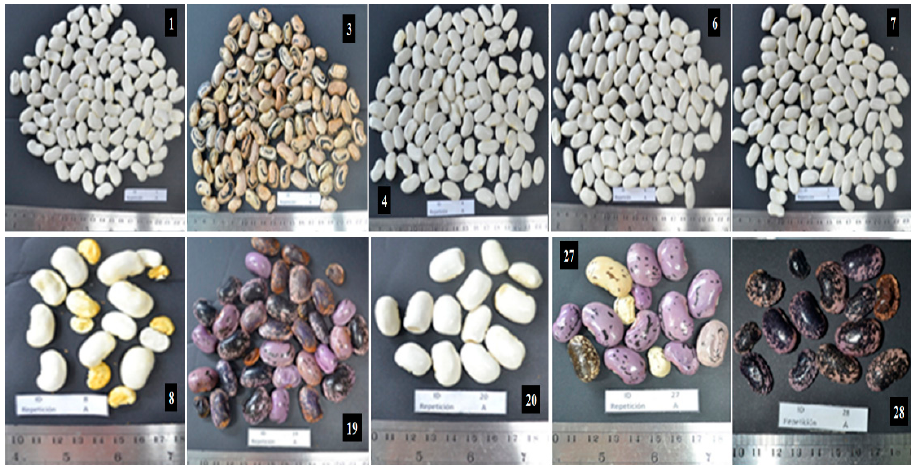
Figure 2. Shape and color of the seeds of each of the P. coccineus lines evaluated. Lines 1, 3, 4, 6, 7 and 8 come from the Central zone of Chile (INIA-La Platina), and lines 19, 20, 27 and 28 come from the Southern zone of Chile (UACH and PUC-Villarica).